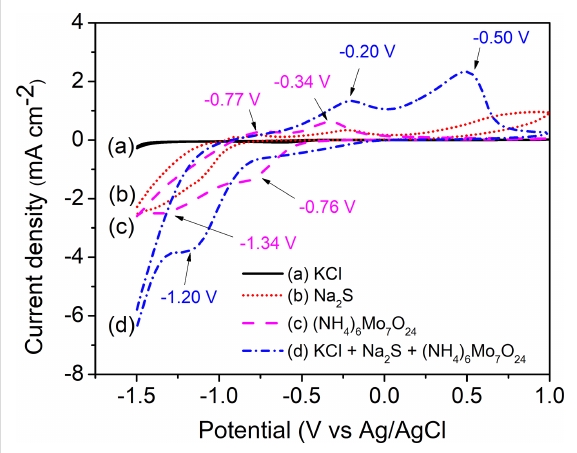
Figure 1: CV curves recorded in the solutions of (a) 0.1 M KCl, (b) 30 g/L Na 2 S, (c) 5 mM (NH 4 ) 6 Mo 7 O 24 , and (d) a mixture of 30